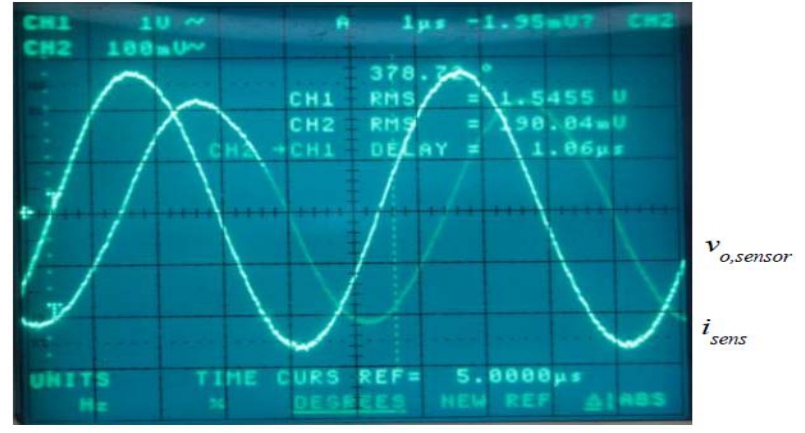
Figure 9. TMR sensor-without magnets output voltage (CH2) vs. sensing current (CH1), I = 1.54 A, f = 200 rms